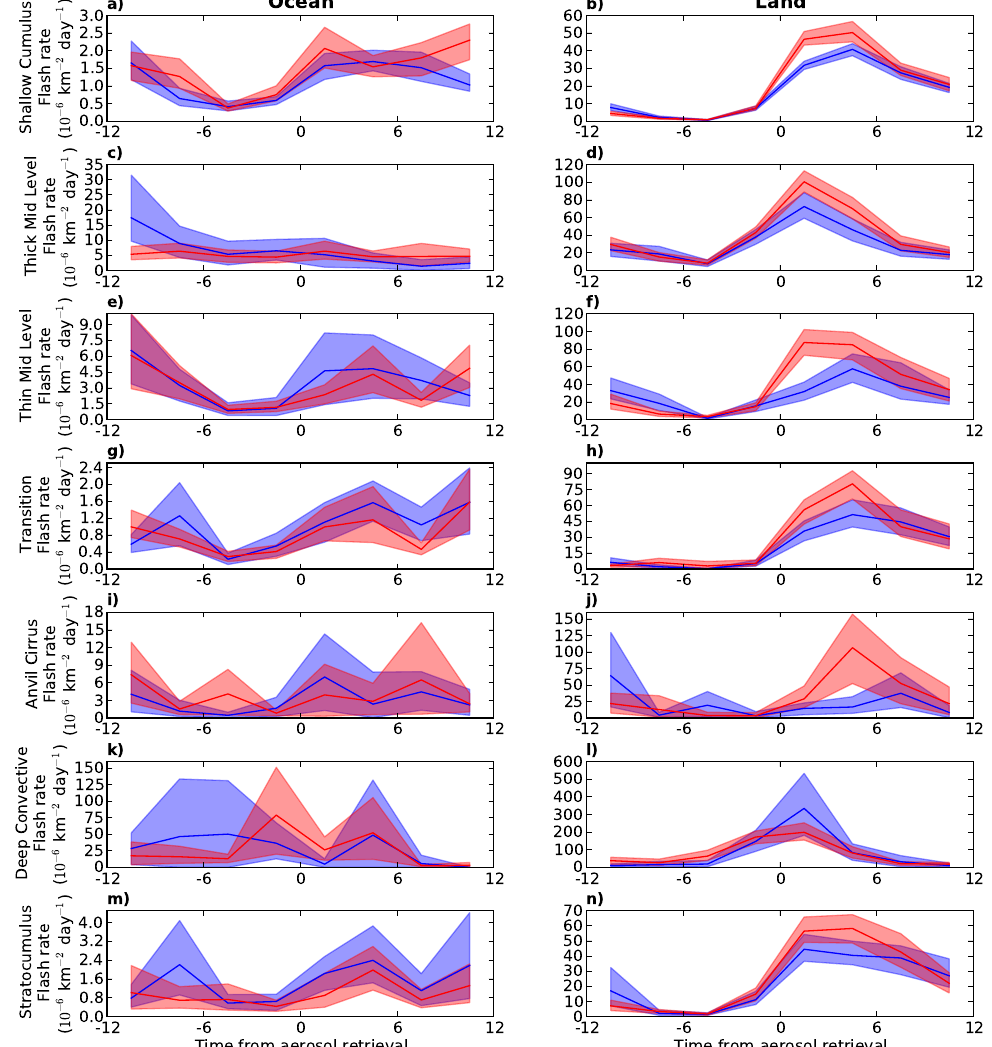
Figure 9. The difference in TRMM LIS flash rate for the high and low AI populations for the study region (30 ◦ N–30 ◦ S, 180 ◦ W–180 ◦ E) over the period 2003–2007. Red indicates the flash rate development for the AI population and blue the low AI